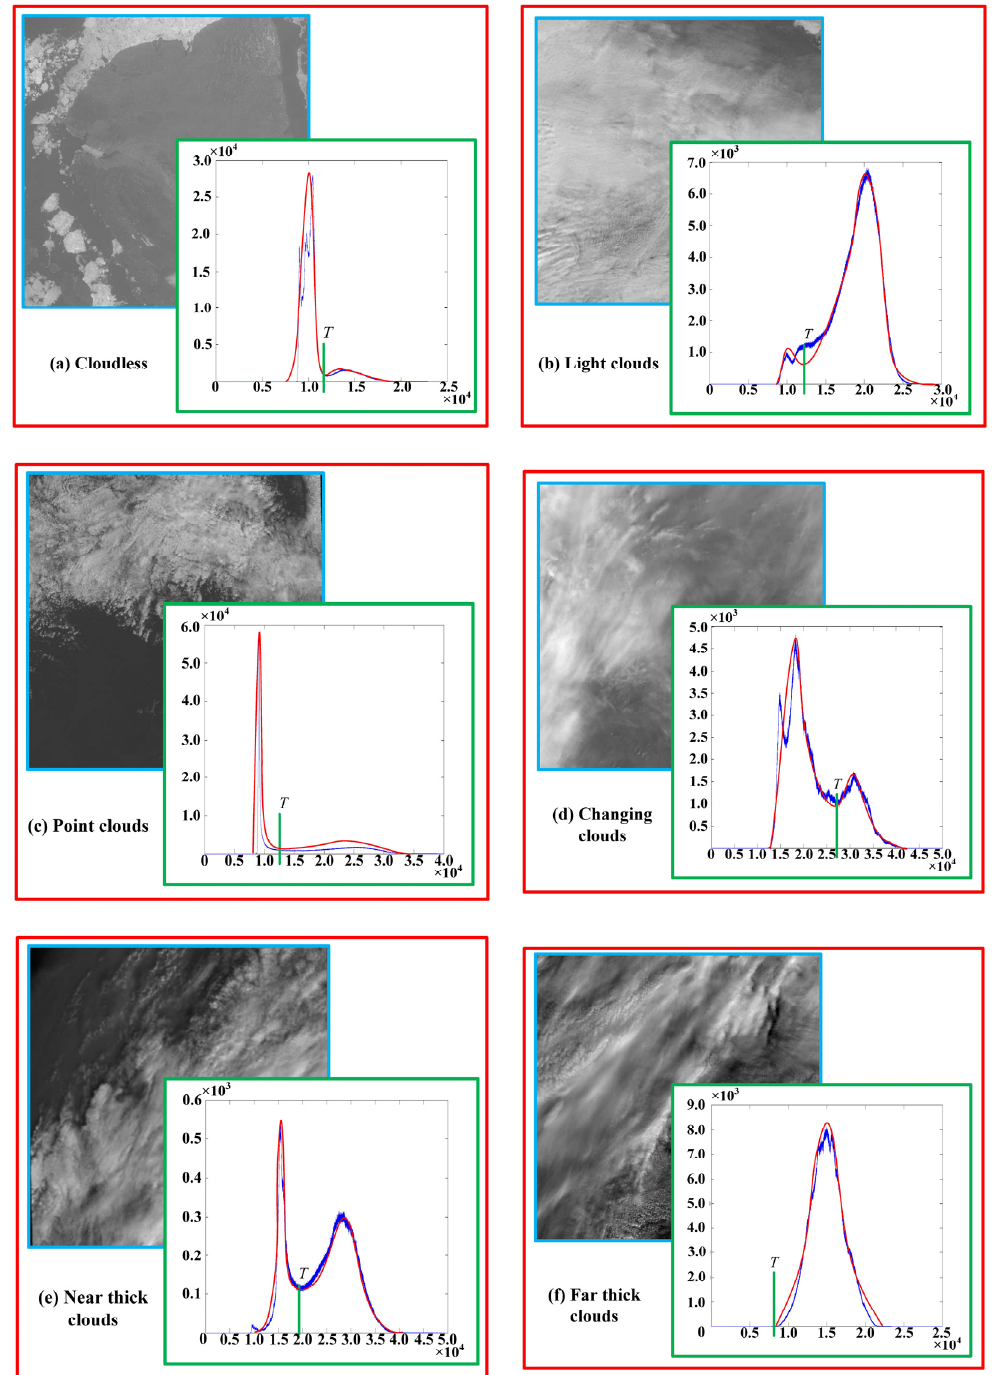
Figure 12. Performance of the cloud detection algorithm.